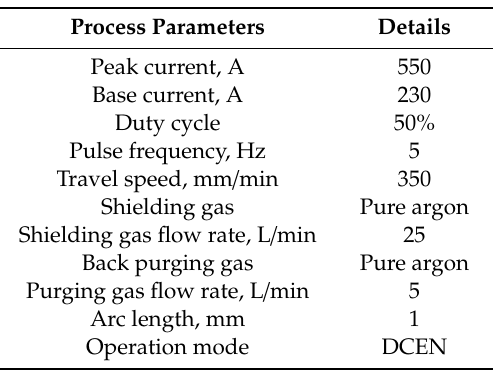
Figure 2. Schematic of the Keyhole Gas Tungsten Arc Welding (K-GTAW) welding process in combination with the interlayer. Table 2. Fixed welding